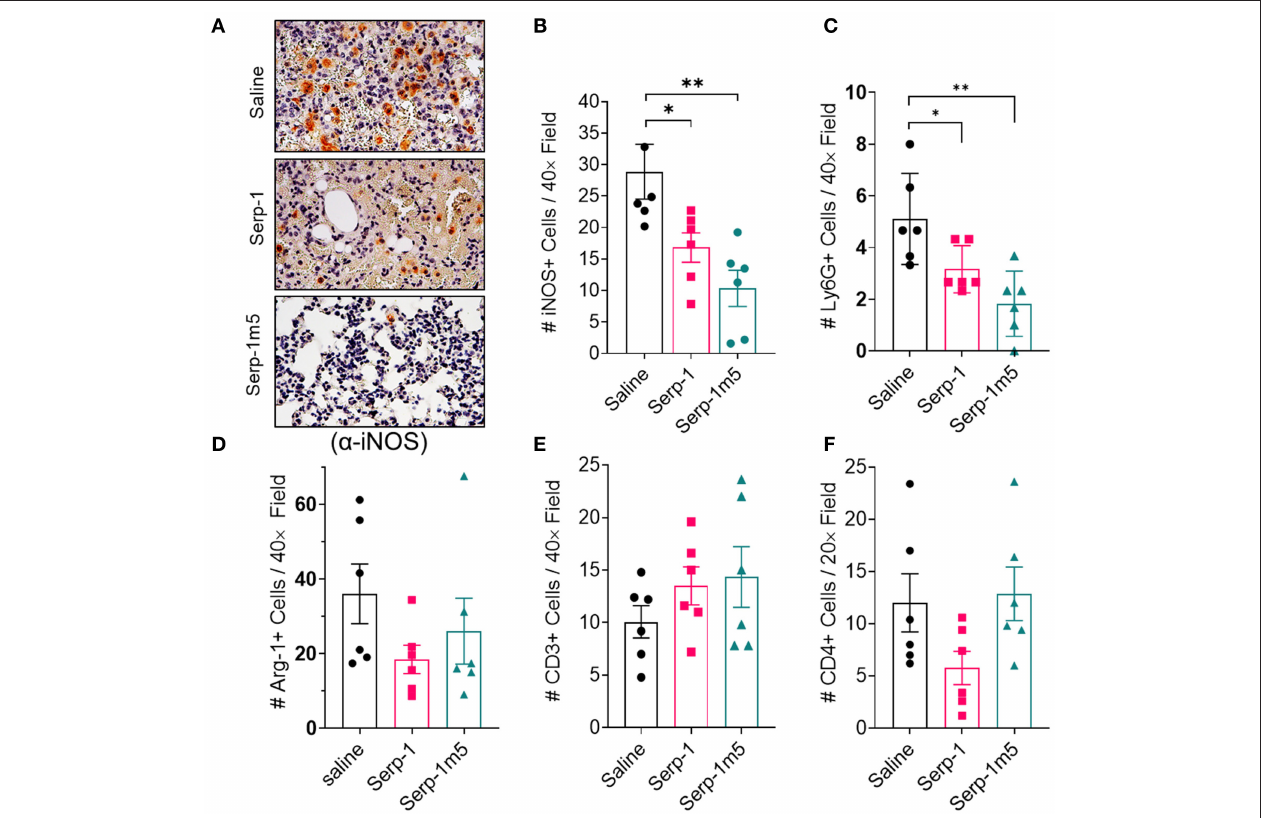
FIGURE 5 | DAH Serp-1 and Serp-1m5 treatments reduced M1 macrophage and neutrophil numbers in lung sections after pristane-induced DAH, but did not significantly affect M2 macrophage counts, CD3 + cell, or CD4 + cell infiltration. (A) Representative micrographs (40 × ) of iNOS + IHC staining in lungs at 14 days post-pristine injection. (B) Serp-1 and Serp-1m5 group had significantly lower numbers of M1 macrophage counts marked by positive staining for iNOS IHC staining (Serp-1, p = 0.0350; Serp-1m5, p = 0.0053) when compared to the saline treatment group. (C) The Serp-1m5 treated group had significantly lower numbers of Ly6G + neutrophils (Serp-1, p = 0.0371; Serp-1m5, p = 0.004). Serp-1 treatment had a strong trend toward reduced neutrophil counts, but did not reach significance. The number of Arg-1 + M2 macrophages (D) , CD3 + T cells (E) , or CD4 + T cells (F) were not statistically different among the three groups, although